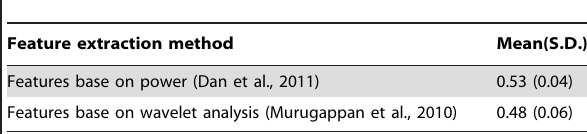
Table 11. Classification Accuracy by Features Extracted from Signal Electrode.